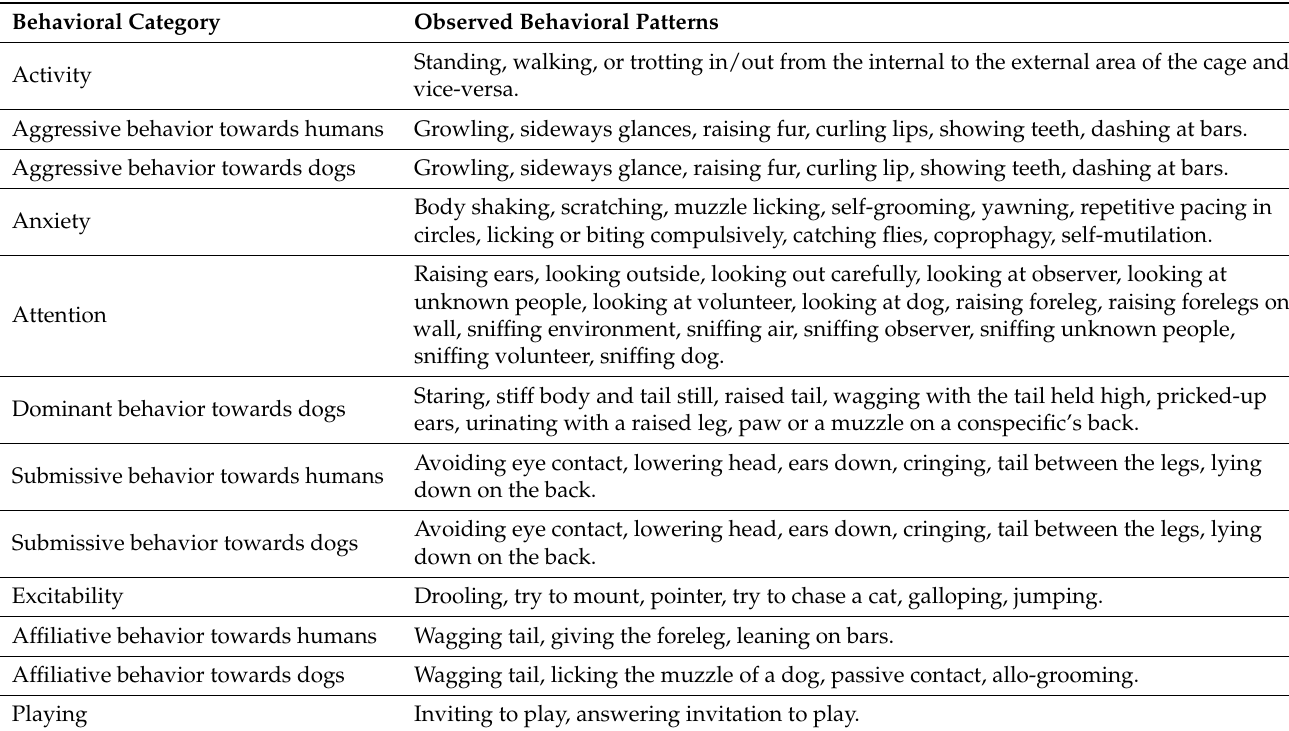
Table 1. The behavioral categories utilised for the PCA as